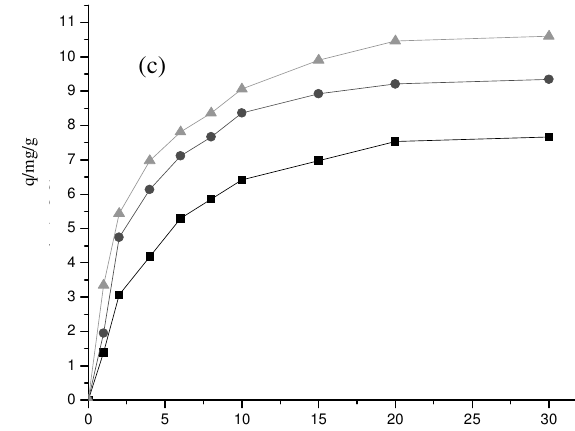
Figure 4. Influence of PVA (500) concentration and temperature on adsorbance, (a) 50 mg/L, (b) 100 mg/L, (c) 200 mg/L; ( ■ )25 °C, ( ● )35 °C, ( ▲ )45 °C